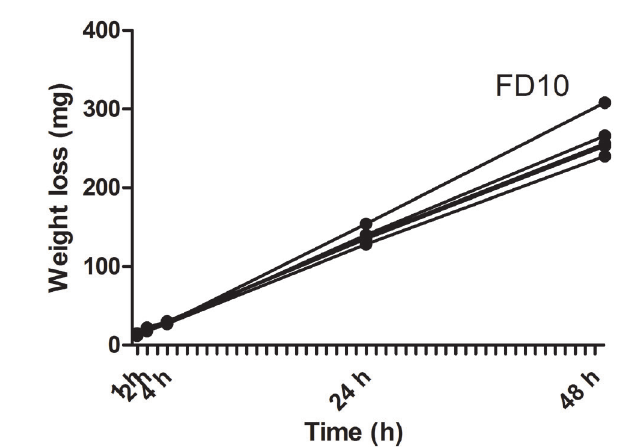
FIGURE 5 - Weight loss (mg) obtained for FD10.